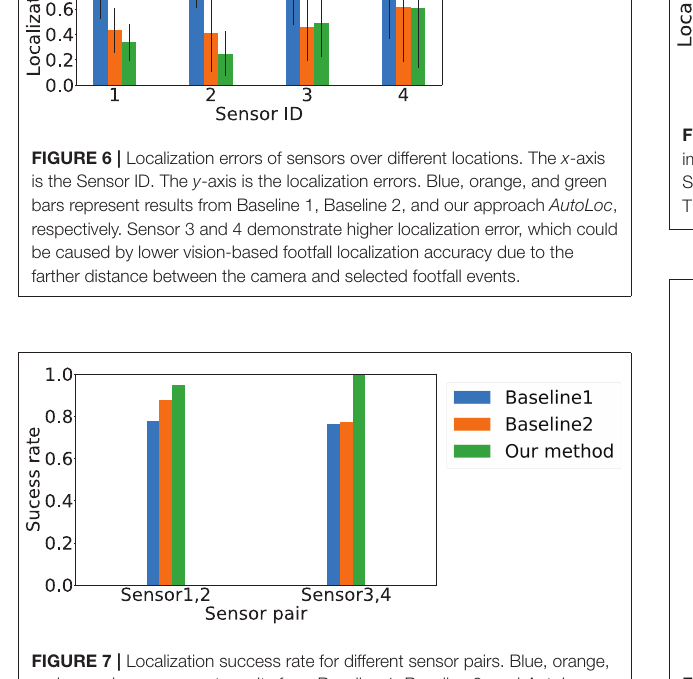
FIGURE 9 | Vision-based footfall event detection parameter motionTh and its impact on localization success rate.